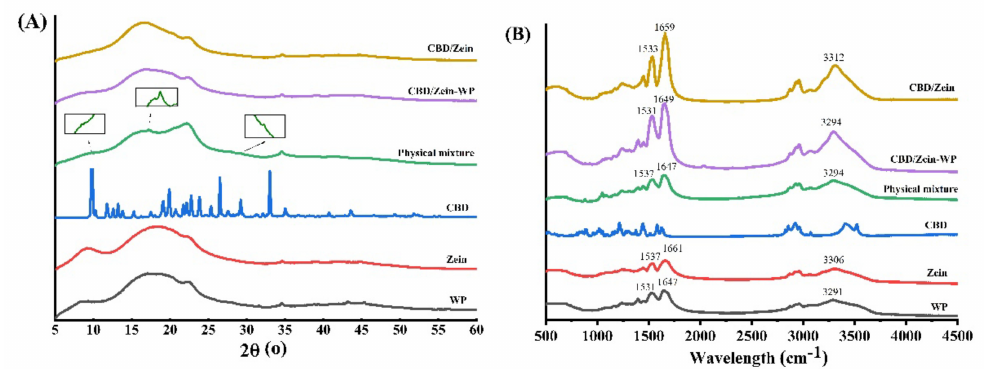
Figure 4. X-ray diffraction (XRD) patterns ( A ) and Fourier transform infrared (FT-IR) spectra ( B ) of WP, zein, CBD, a physical mixture (CBD, WP and zein), CBD-loaded zein nanoparticles (CBD/zein), and CBD-loaded zein–WP nanoparticles